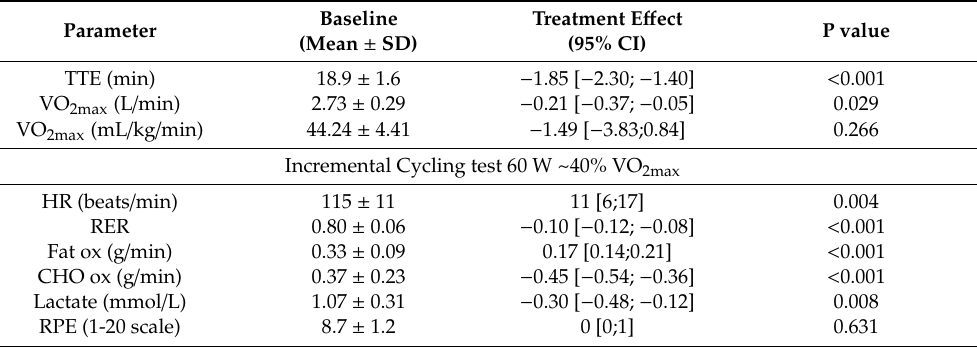
Table 4. Graded incremental ergometer cycling test baseline measures and treatment e ff ects after eating a ketogenic LCHF diet for 25–27 days 1